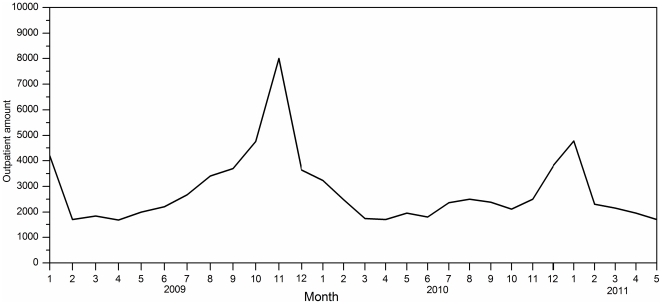
The adult outpatient service capacity of the Infectious Diseases Department of PKUPH, 2009–2011.In 2010, the overall number of outpatients was less than that of 2009, particularly between May and December. From May 2009, when pH1N1 emerged in Beijing, the capacity of the outpatient service of the Infectious Diseases Department of PKU People's Hospital increased rapidly. The number of outpatients peaked in November 2009, following which. The volume declined to reach normal levels in the third month of 2010. The numbers of outpatients was relatively stable in 2010, with an increase during November and December and a further peak in January 2011.